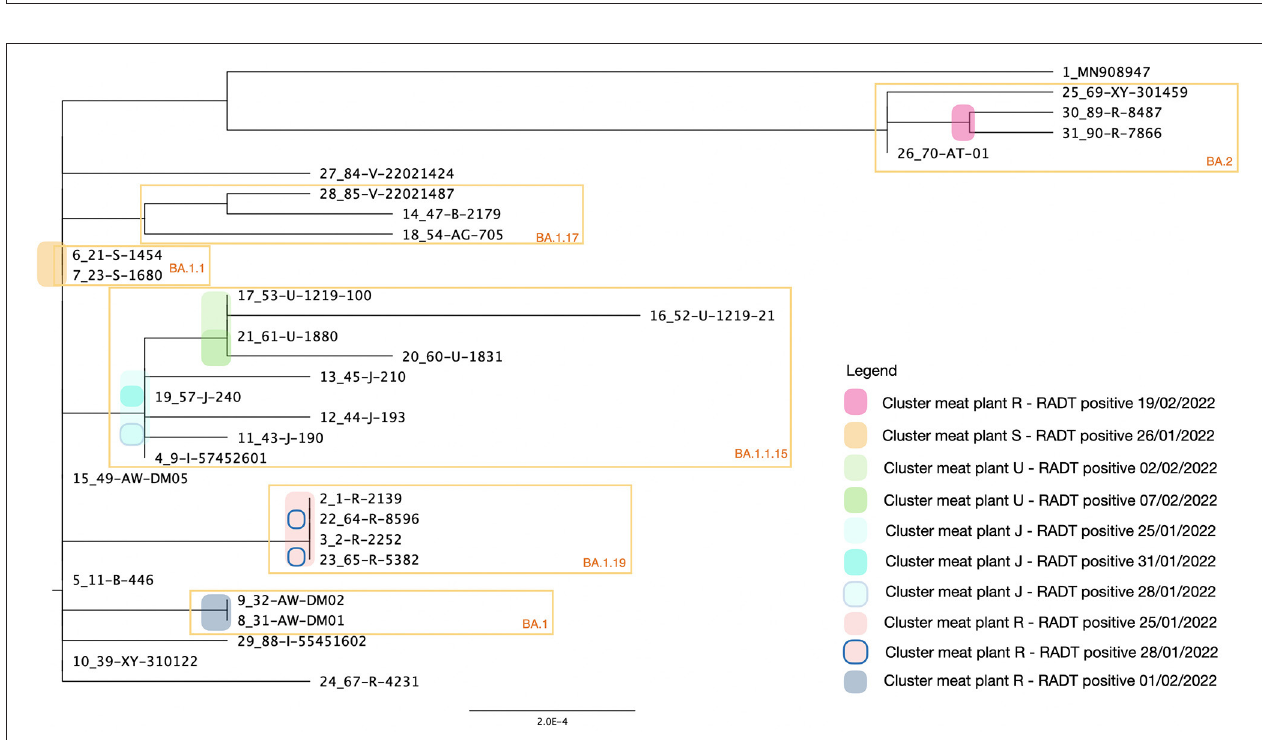
FIGURE 4 | Sequence alignment of WvG sequences obtained from RNA during the stability test. The spiked RADTs were stored at 4 ◦ C and 20 ◦ C after the addition of buffer AVL and the extraction protocol was performed after 2 and 7 days. The GenBank id of the four samples are included in the left side of the figure, the Human nCoV19 isolate/England/MIG457/2020 used for the spiking is included. The colored lines represent the mutations and polymorphisms common to the four WvGs compared to the reference WvG (MN908947 - Severe acute respiratory syndrome coronavirus 2 isolate Wuhan-Hu-1).